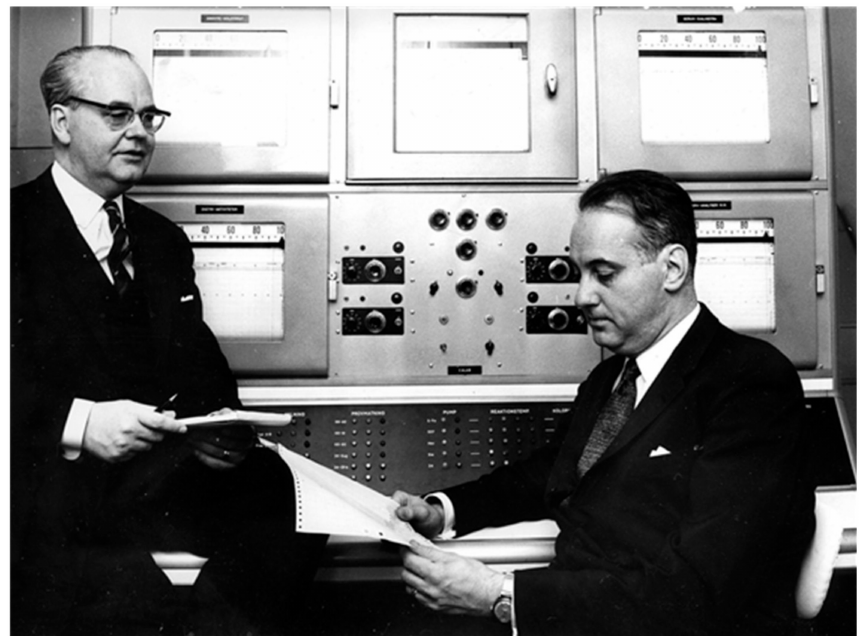
Figure 7. The Jungner brothers in front of the Värmland equipment in